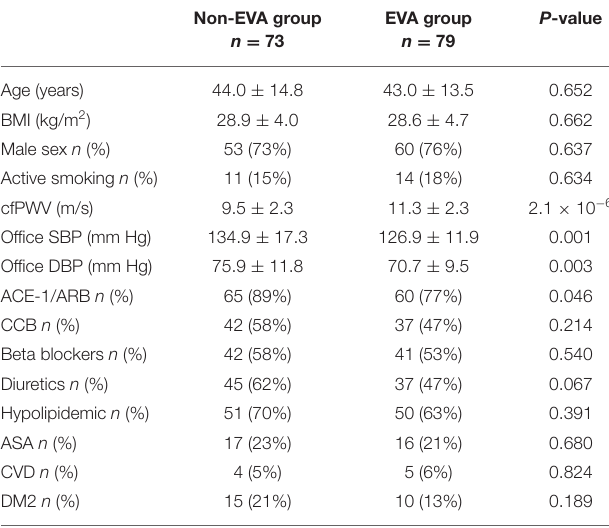
TABLE 1 | Study population